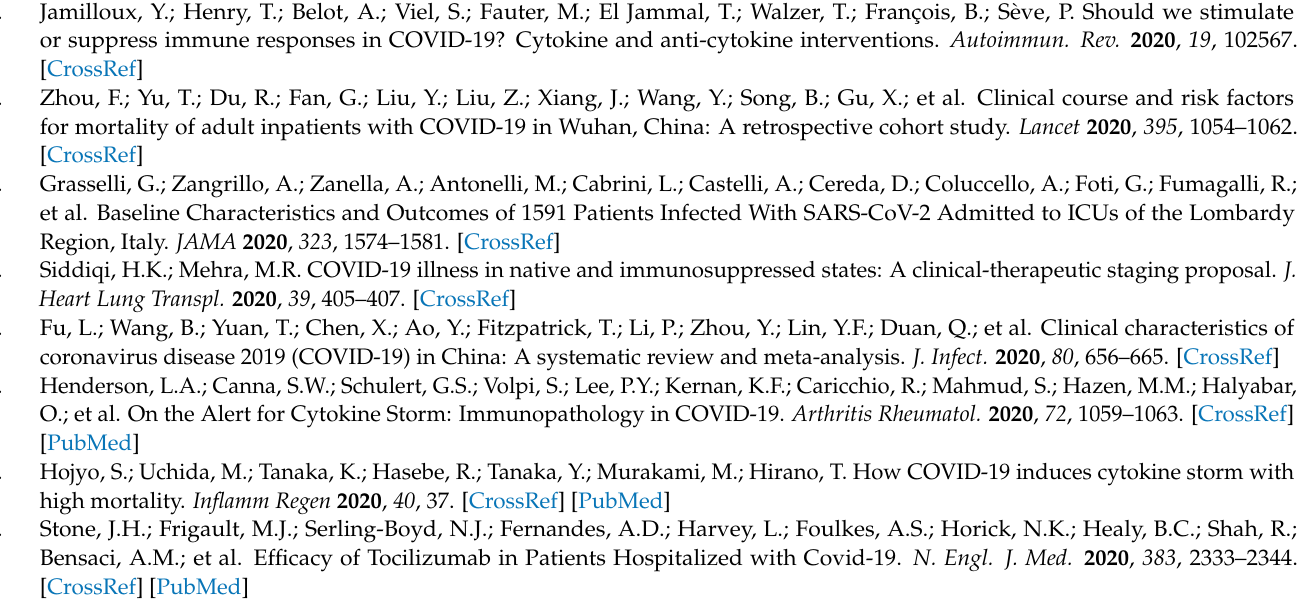
Figure S2. Renal toxicity levels by COVID-19 patient characteristics at baseline, Table S1. Distribution of cytokine, renal toxicity marker levels by COVID